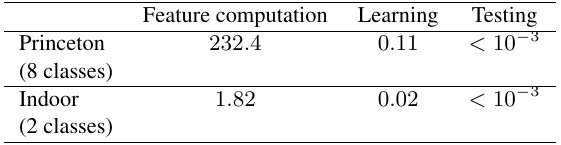
Table 2: Running times (in